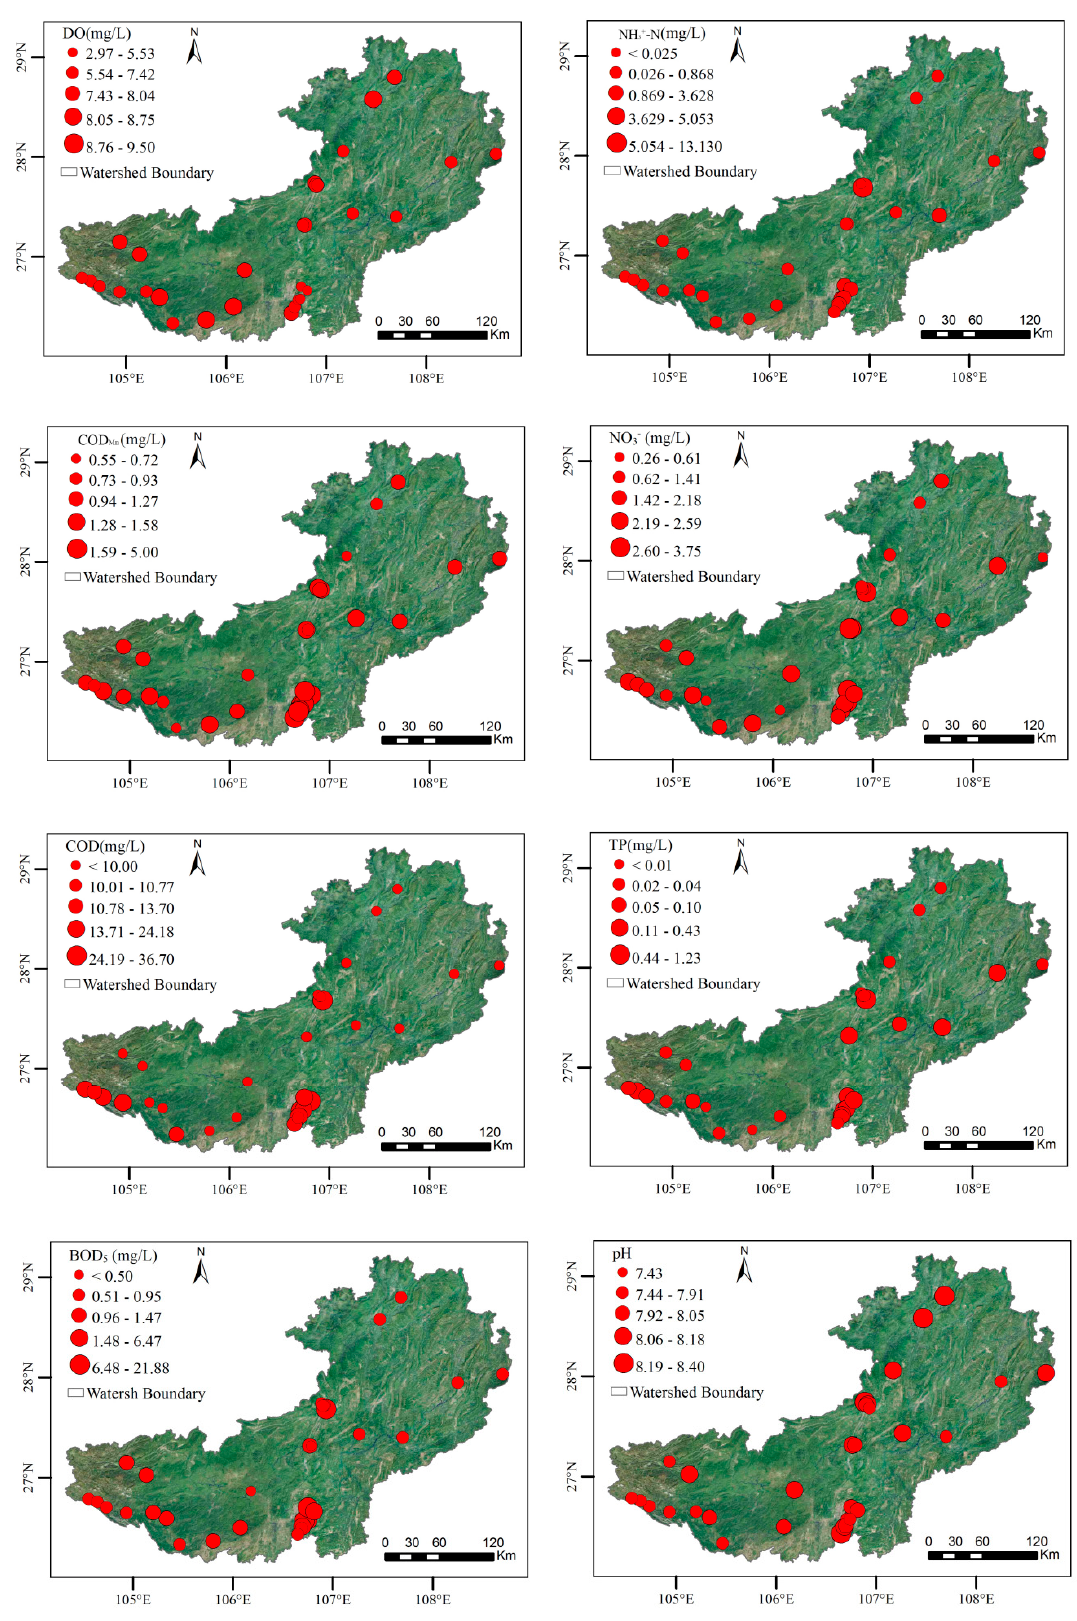
Figure 3. Spatial variation of water quality indicators in Wujiang river watershed. Range of values were categorized into five classes using the natural breaks method.